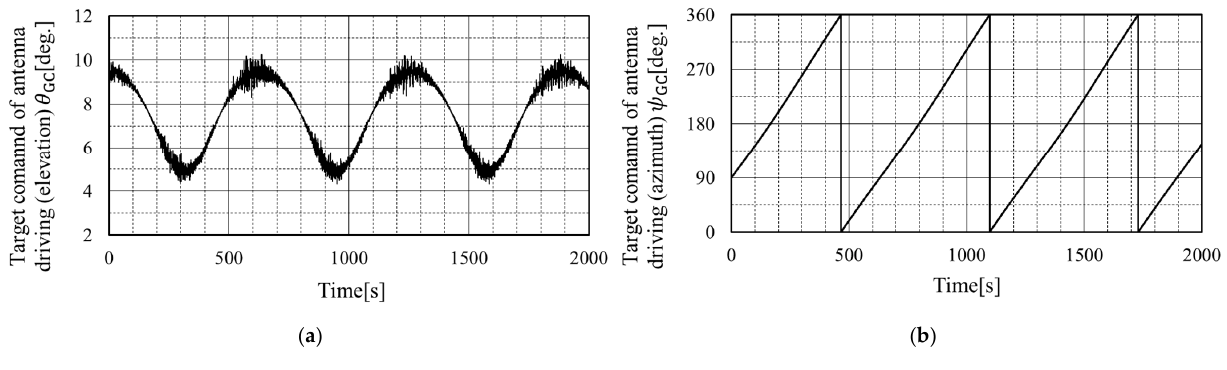
( b ) Figure 22. Time history of the antenna’s pointing directions. ( a ) Elevation. ( b ) Azimuth.